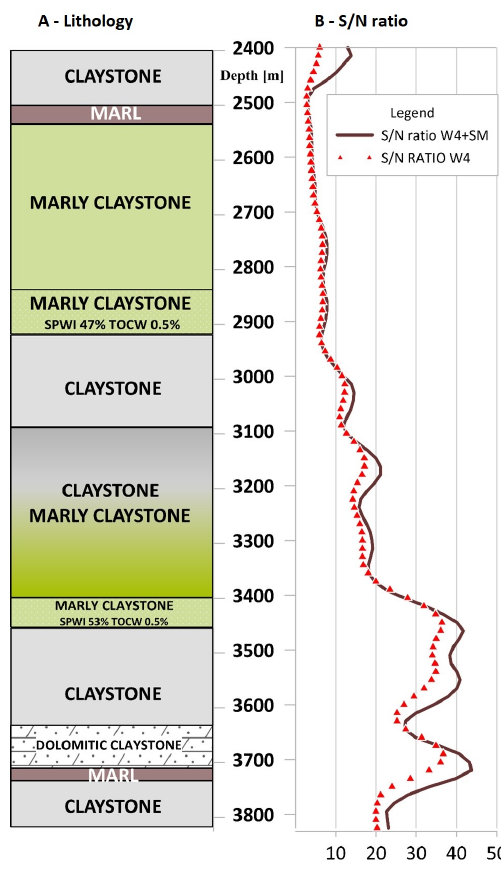
Figure 10. Lithostratigraphic column in Well W-1 with S/N ratio graph for W4 ( red triangles ), and W4 with signal-matching procedure added ( brown solid line ).